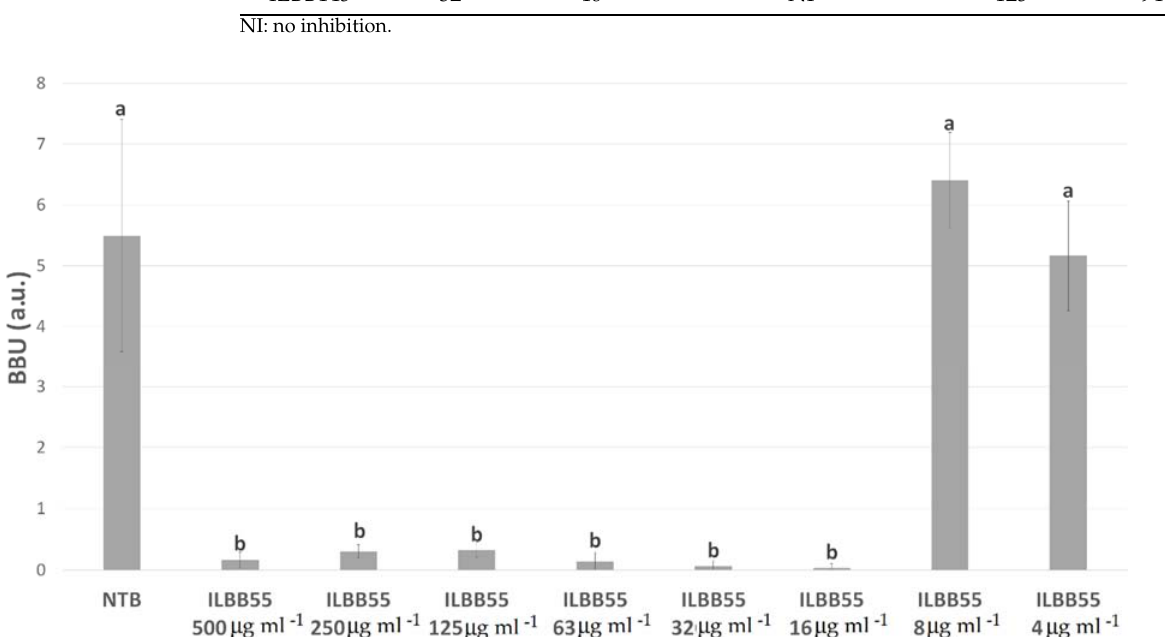
Figure 2. Inhibition of Staphylococcus aureus biofilm by different concentrations of ILBB55 extract. Different letters (a, b) represent significant differences ( p < 0.05)